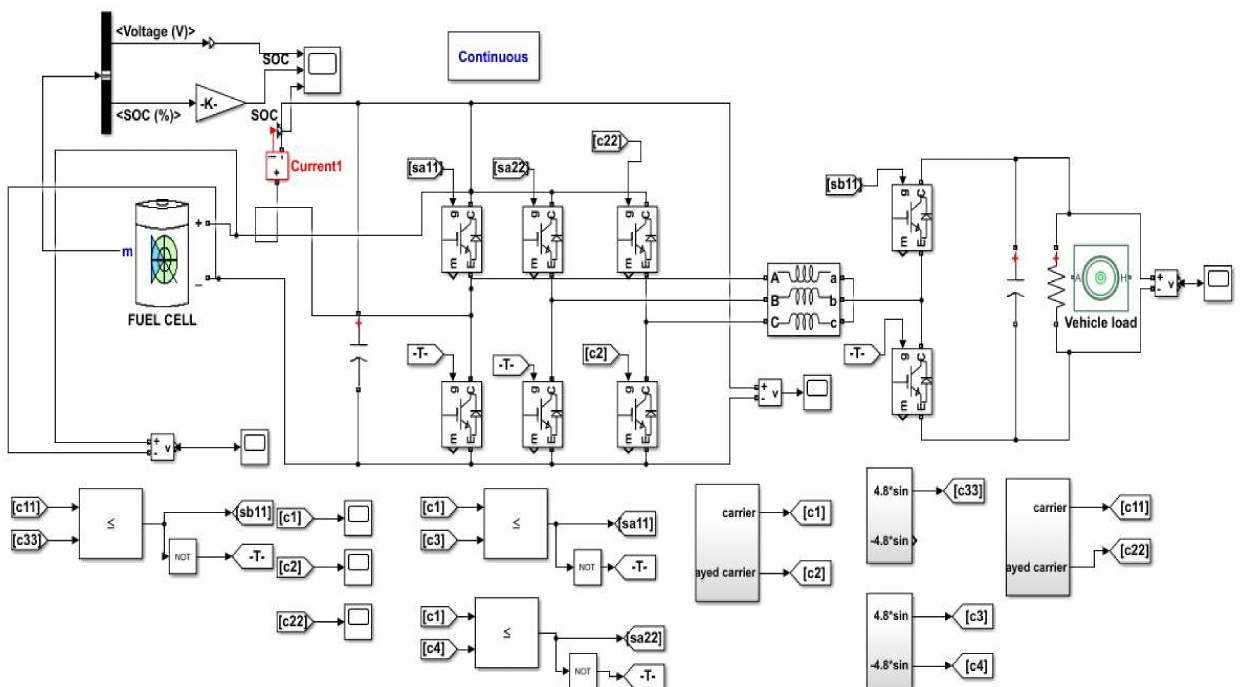
Figure 7. Simulink model for the proposed method with a high-gain converter.